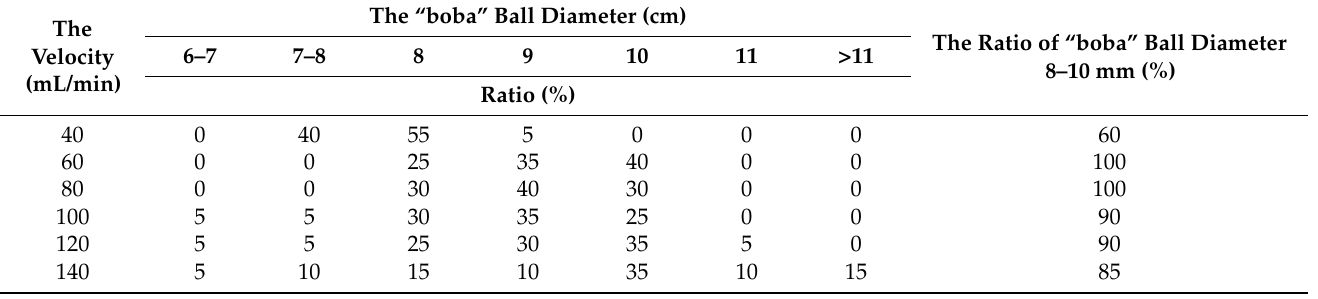
Table 2. Influence of flow velocity on the “boba” ball diameter.